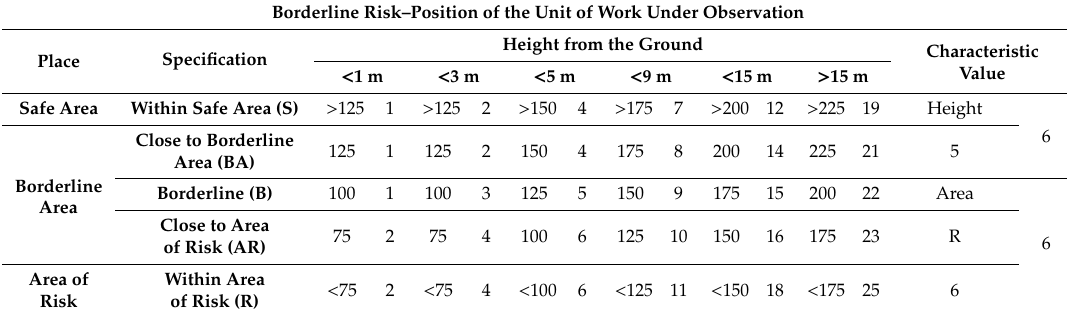
Table 5. Example of characteristic value in borderline